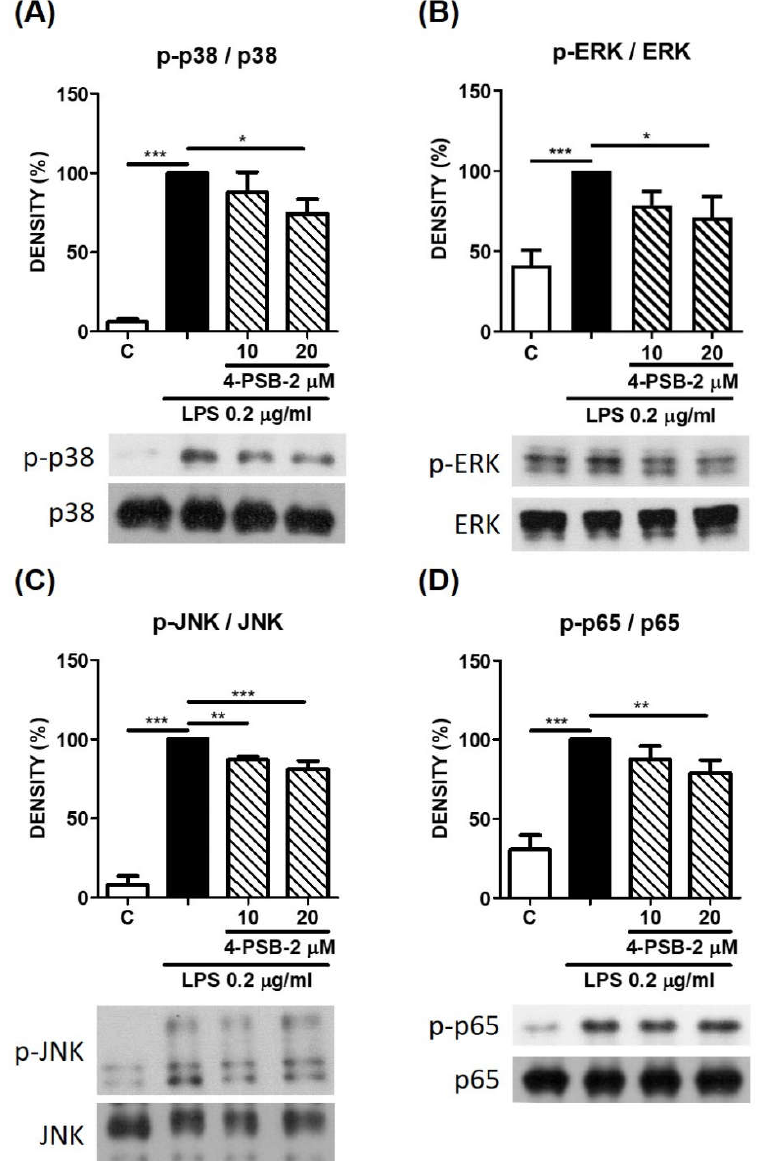
Figure 4. 4-PSB-2 could significantly suppress LPS-induced p-MAPK and p-p65 expression in THP-1 cells. After pretreatment with medium alone ( C ) or 4-PSB-2 for 2 h followed by LPS stimu- lation for 1 h, the p-p38 ( A ), p-ERK ( B ), p- JNK ( C ), and p-p65 ( D ) expression were determined by Western blot. Data present the means ± SD of 3 independent experiments. (* p < 0.05, ** p < 0.01, and *** p <